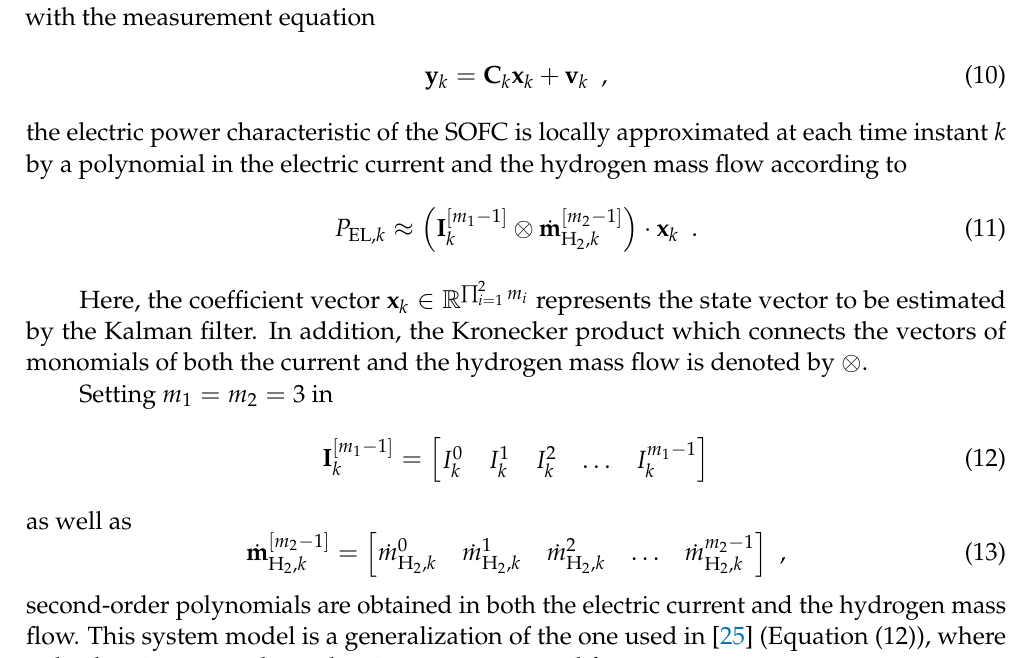
voltage prediction (static) voltage prediction (dynamic) voltage prediction ( G IO ( s ) ) voltage prediction ( G FO ( s ) , n = 1) voltage prediction ( G FO ( s ) , n = 3)